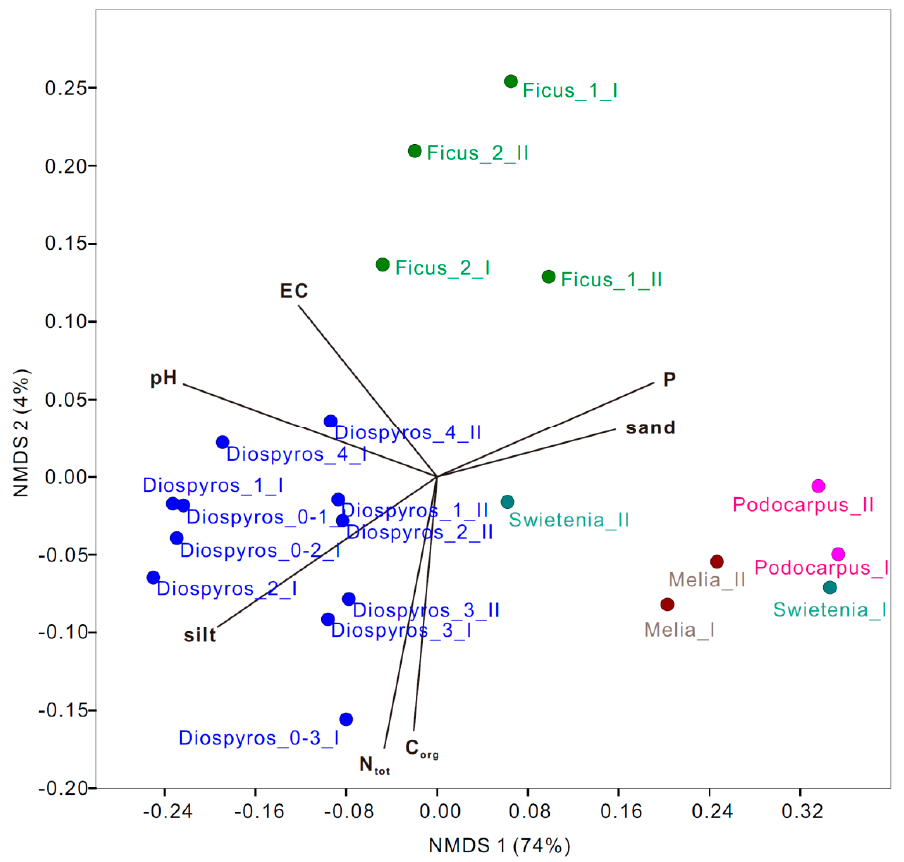
Figure 4. NMDS ordination of the nine urban trees at two study sites across the treatments based on bacterial community compositions at the species level (>1% relative abundance). Soil physicochemical parameters with a significant goodness of fit based on post hoc correlations ( p ≤ 0.05) are represented as vectors.